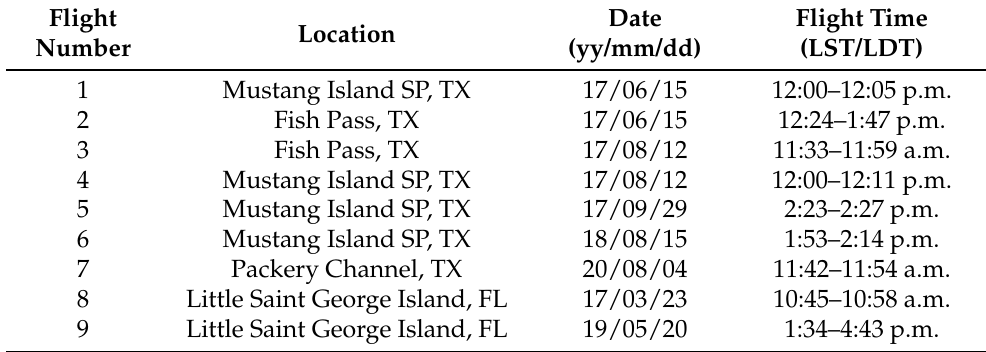
Table 4. UAS Flight Location and Time Information.